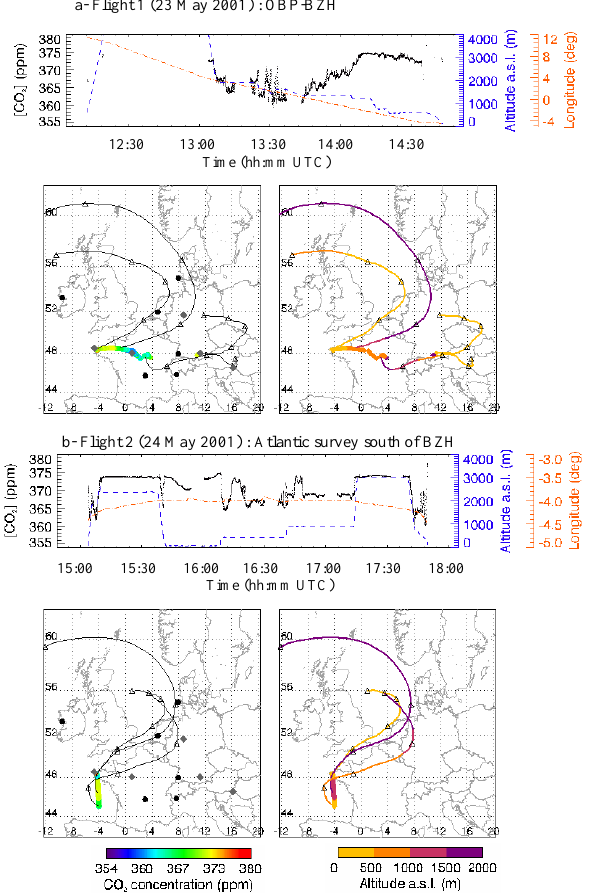
Fig. 5. (c, d) Back-trajectories computed over 96h for flight 3 and flight 4. The distance between 2 triangles is 24h. Left panels show CO 2 concentrations along the flight path and back- trajectories. Right panels show the altitude of the flight, and back- trajectories colored according to air mass altitude. Black circles rep- resent ground stations named in Fig. 1. Altitude is given in meters above the sea level (ma.s.l.). Note that some of the back-trajectories are outside the latitude and longitude chosen borders, but these are so diluted that they do not give any relevant